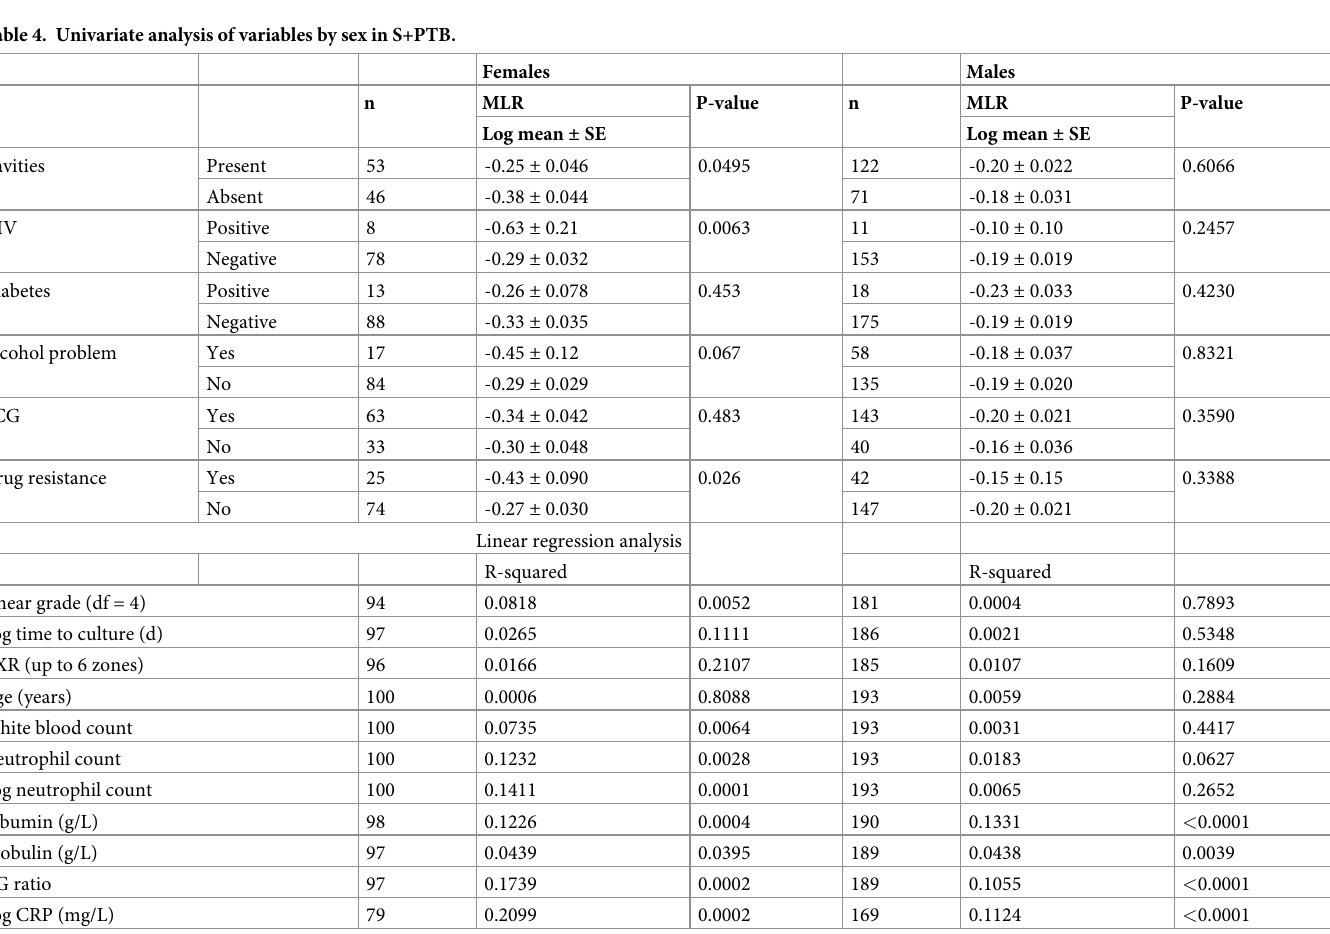
Table 4. Univariate analysis of variables by sex in